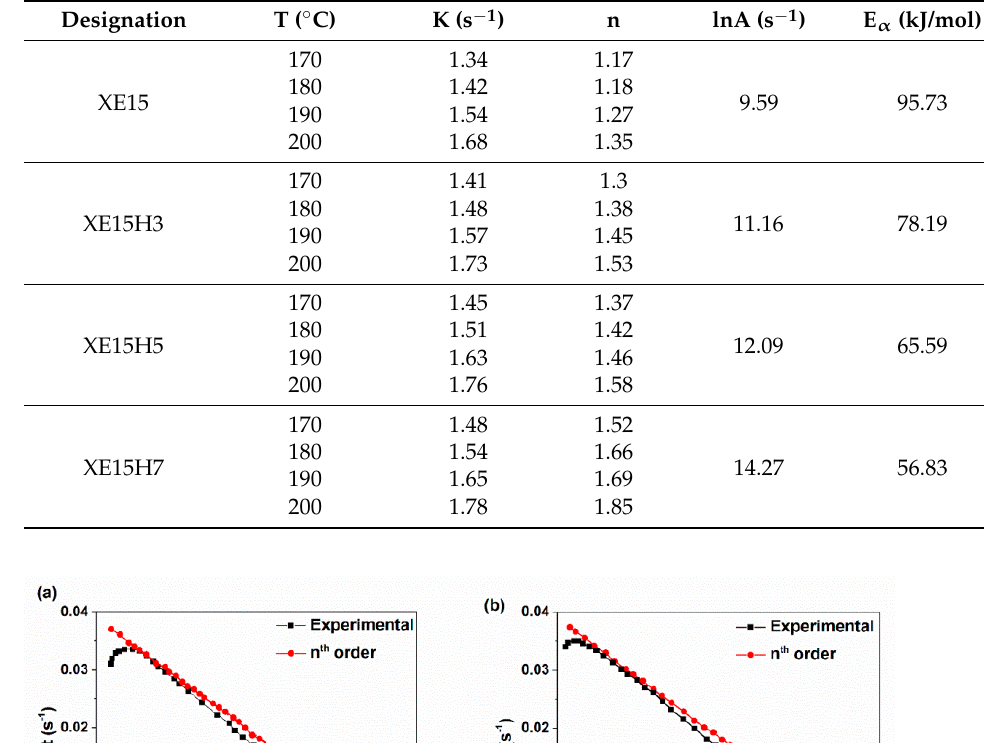
Table 3. Vulcanization kinetic parameters for various XNBR/epoxy/XHNT nanocomposites calcu- lated through using n th order model.